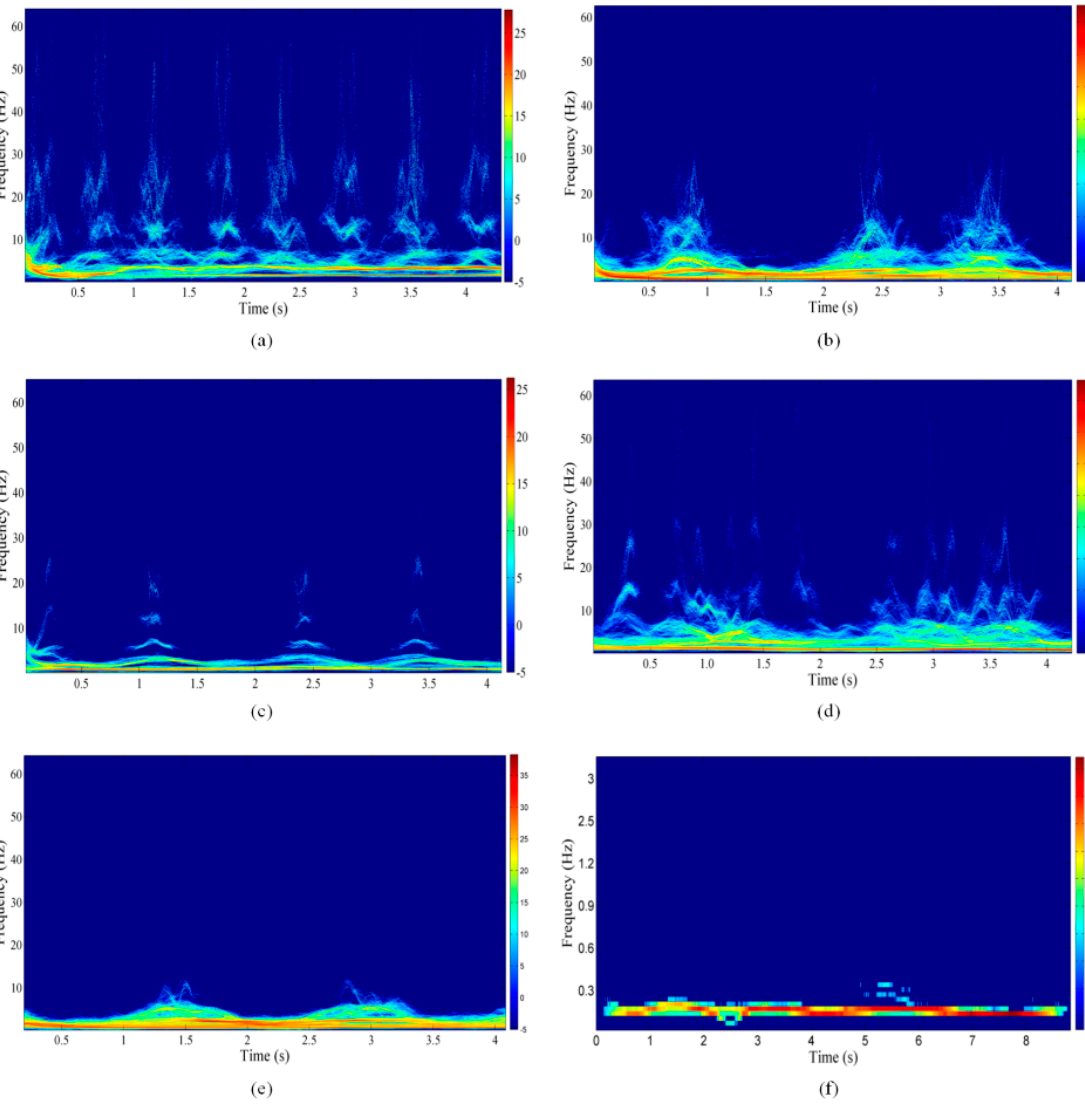
Figure 7. MHHT-based T-F Spectra of a subject performing six kinds of finer-grained human activities while staying at a position 3 m behind the wall: ( a ) piaffe; ( b ) picking up an object; ( c ) waving; ( d ) jumping up; ( e ) standing with random micro-shaking; and ( f ) breathing while sitting